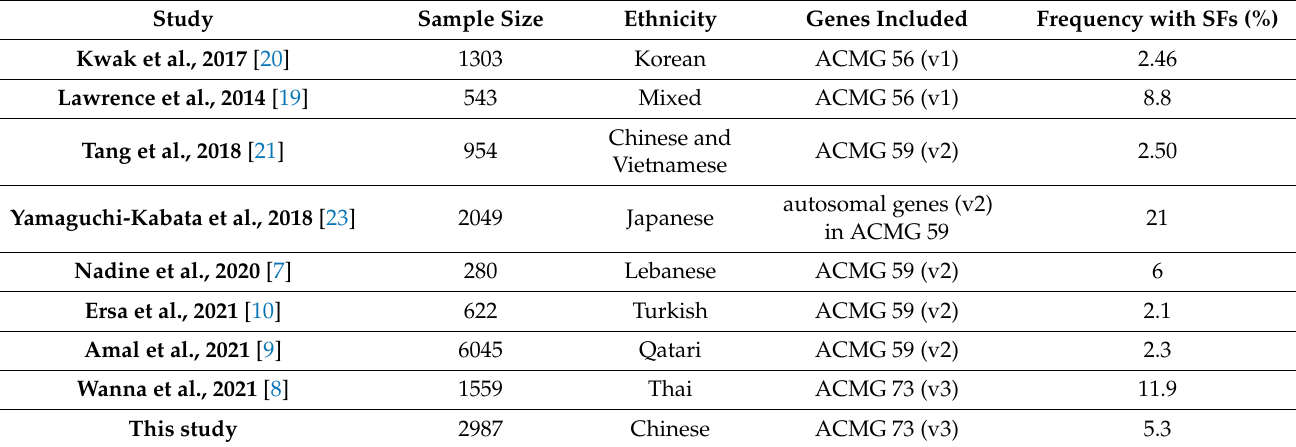
Table 2. Comparison of percentage with secondary findings in different